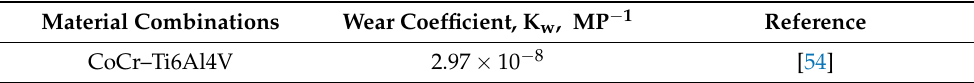
Table 3. Wear coefficient, K w , for different material combinations.